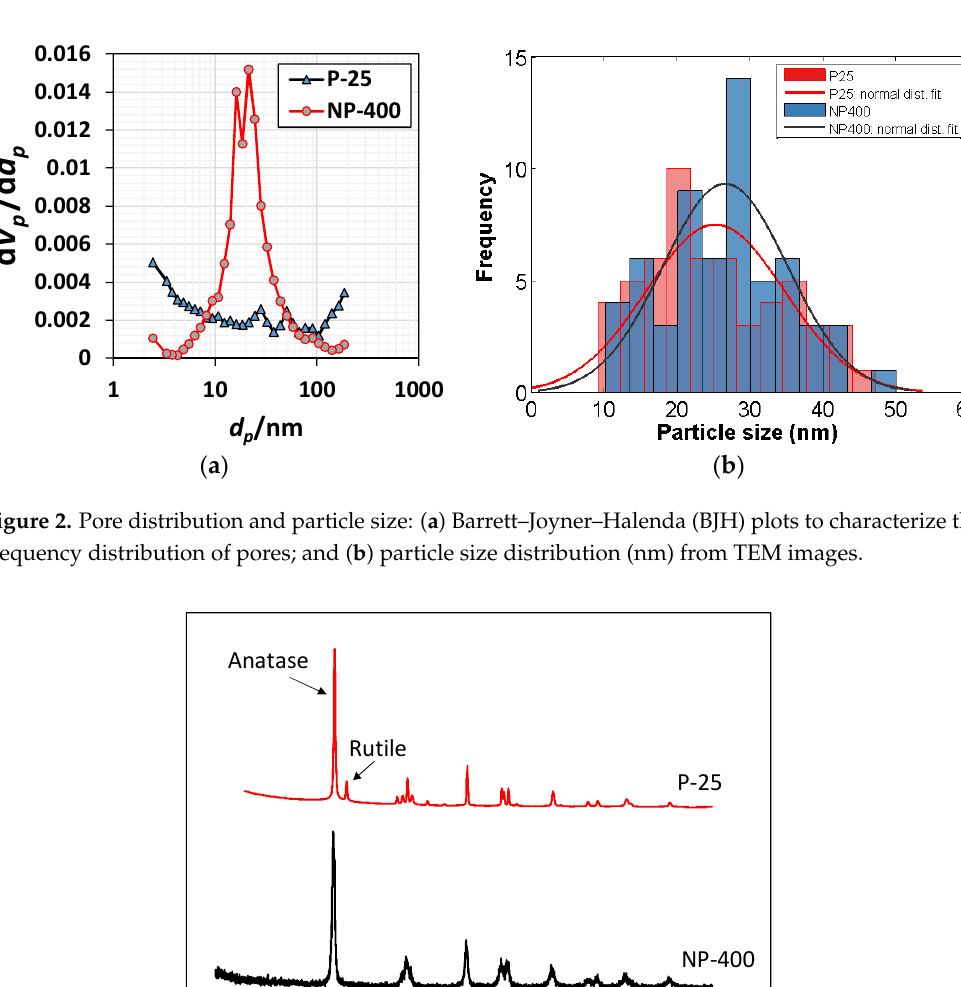
Figure 1. TiO 2 : transmission electron microscope (TEM) images of ( a ) NP-400, Bentech Frontier, Korea; and ( b ) P-25, Evonik, Germany.